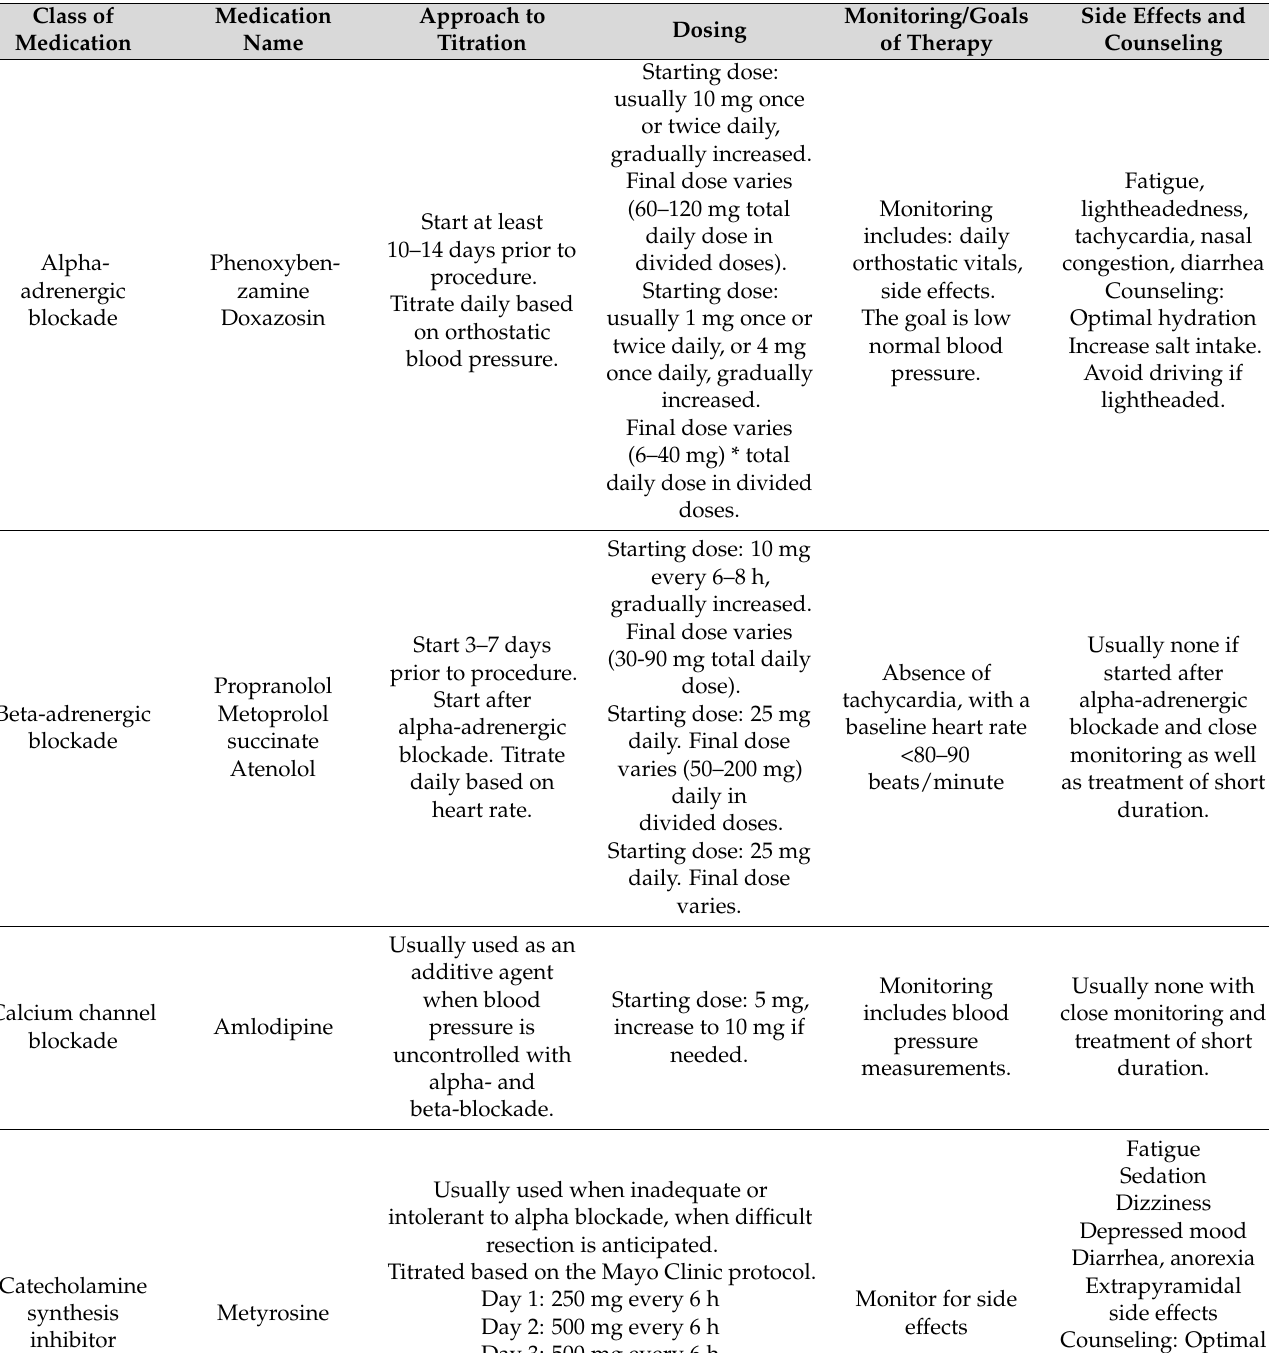
Table 1. Outpatient pre-procedural medical